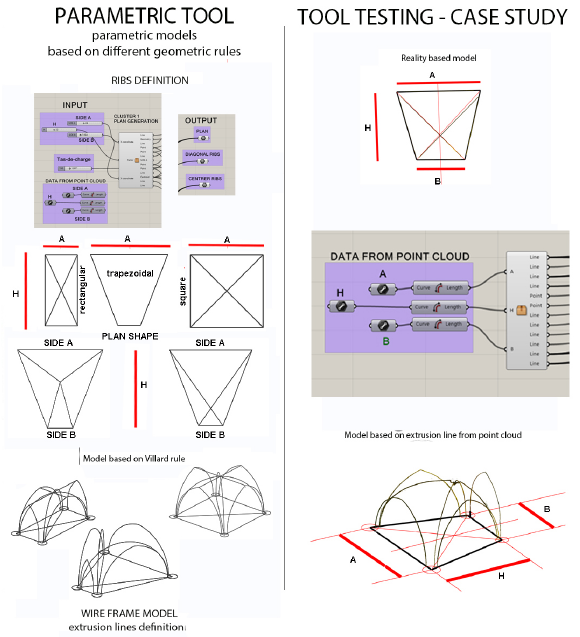
Figure 7 : CLUSTER 1 and CLUSTER 2 Parametric tool for automatic modelling of quadripartite, from square, rectangular to trapezoidal vault.